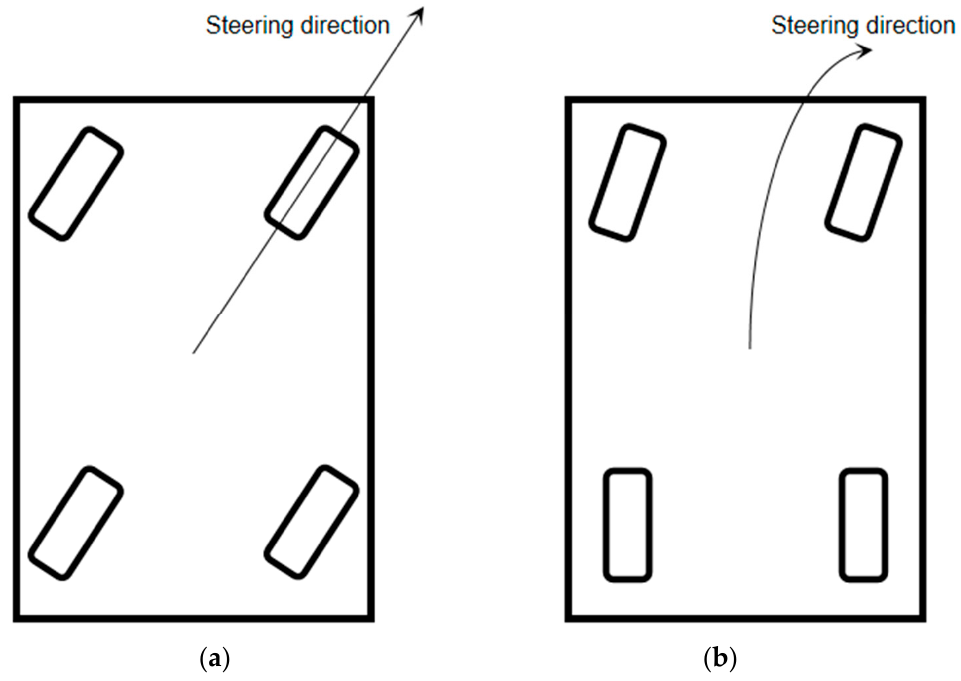
Figure 3. Schematic diagram of two steering schemes. ( a ) Four-wheel co-steering; ( b ) front-wheel steering.